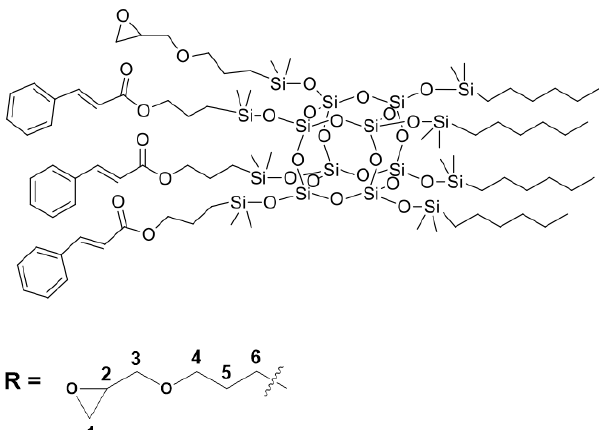
Figure 2. The chemical structure of SSQ2.